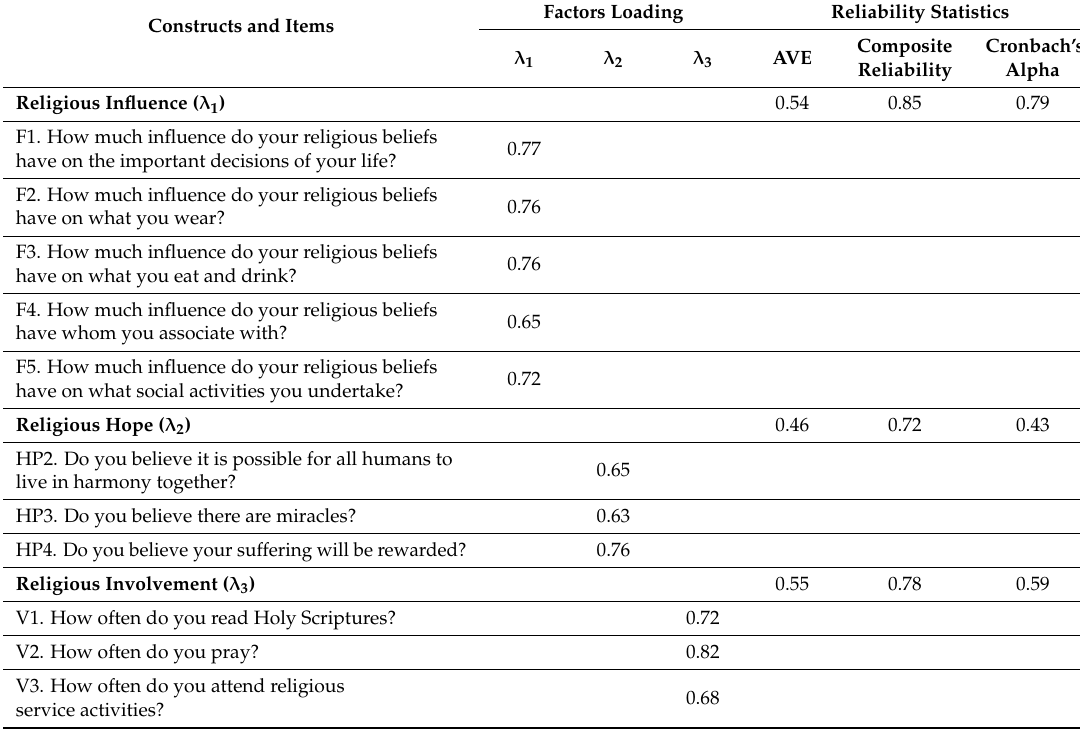
Table 3. Factors loading and reliability statistics for Religiosity.